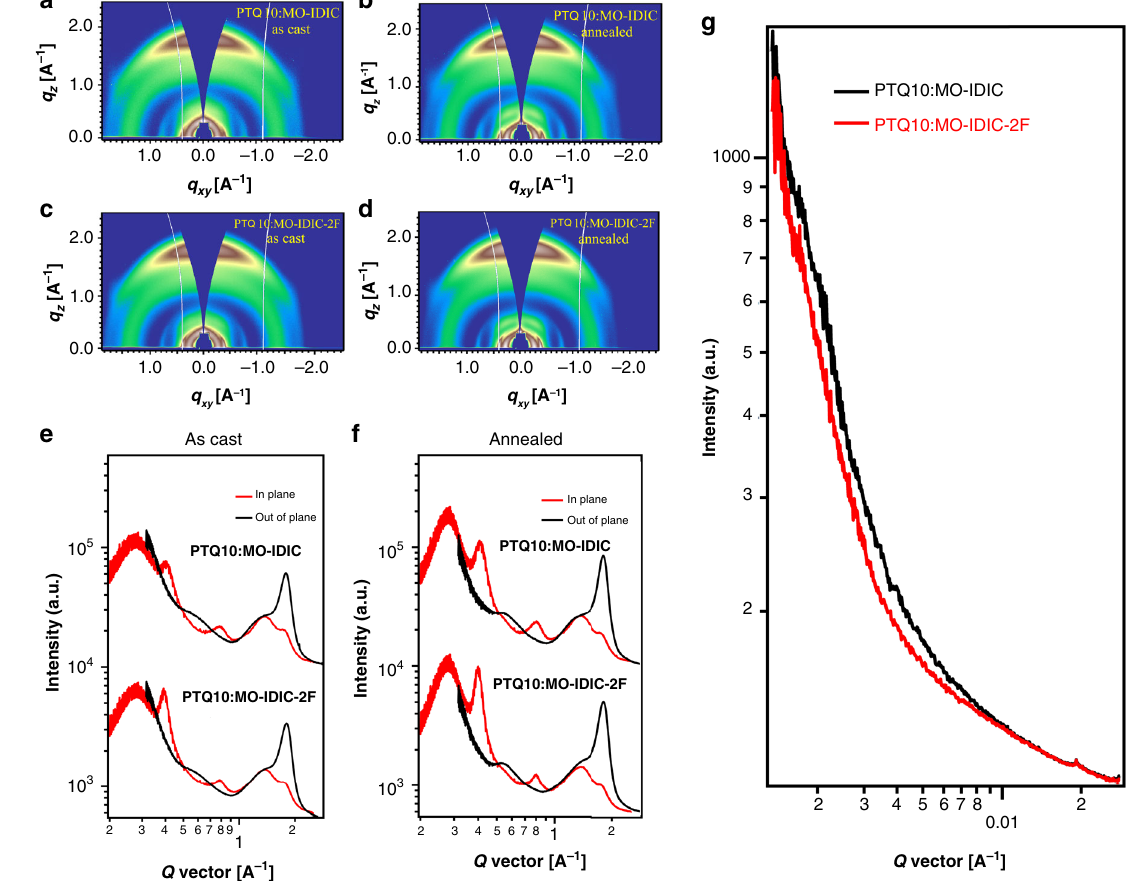
Fig. 4 GIWAXS and RSoXS results of active layers of the PSCs. 2D GIWAXS patterns of a as cast PTQ10/MO-IDIC blend fi lms; b PTQ10/MO-IDIC blend fi lms with thermal annealing at 120 o C for 5 min; c as cast PTQ10/MO-IDIC-2F blend fi lms; d PTQ10/MO-IDIC-2F blend fi lms with thermal annealing at 110 o C for 5 min; e line cuts of GIWAXS images of the as cast PTQ10/acceptors blend fi lms; f line cuts of GIWAXS images of the annealed PTQ10/ acceptors blend fi lms; and g the RSoXS pro fi les of PTQ10/MO-IDIC and PTQ10/MO-IDIC-2F blend fi lms as cast and